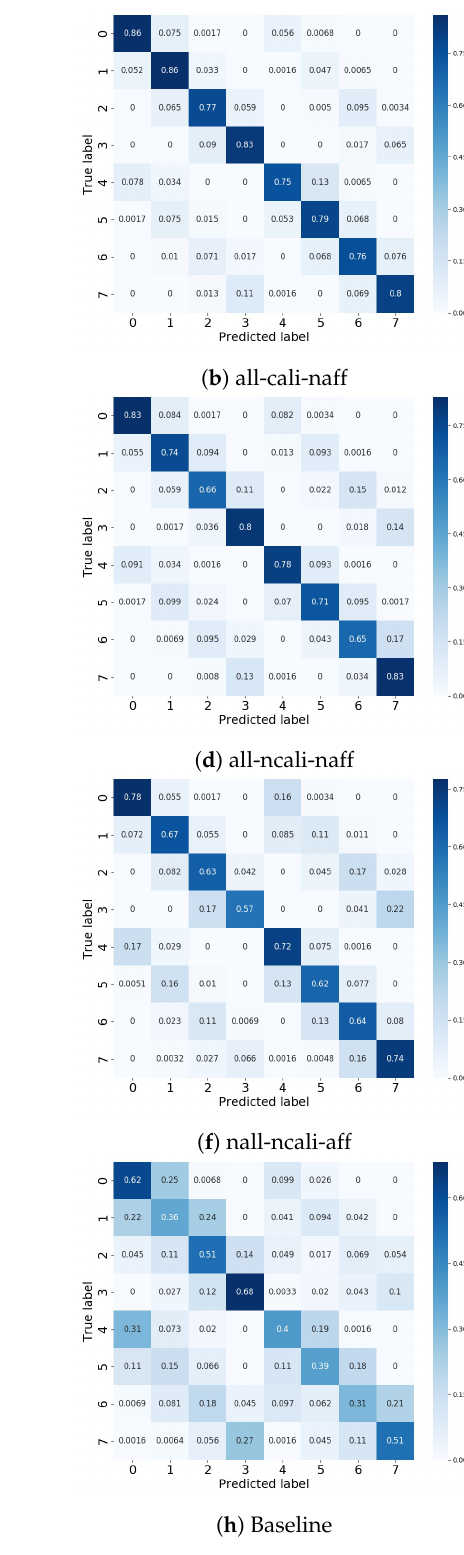
Figure 9. The confusion matrix of the different protocols and